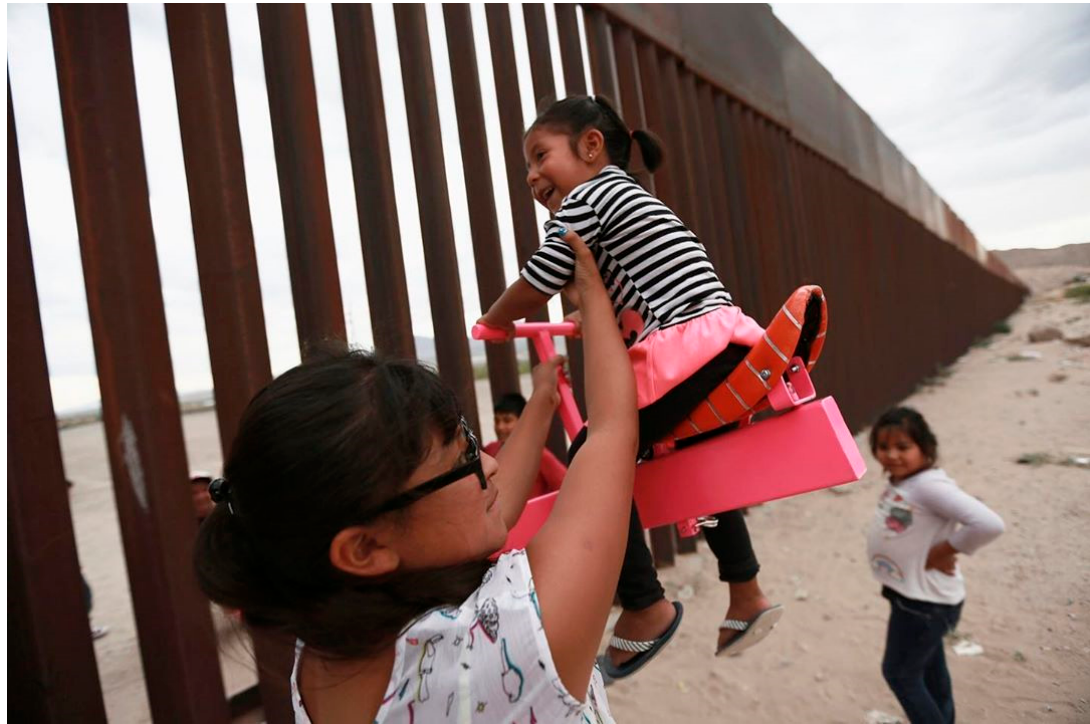
Figure 12. Young child playing with installed teeter-totter (Photo graciously provided by Ronal Rael).